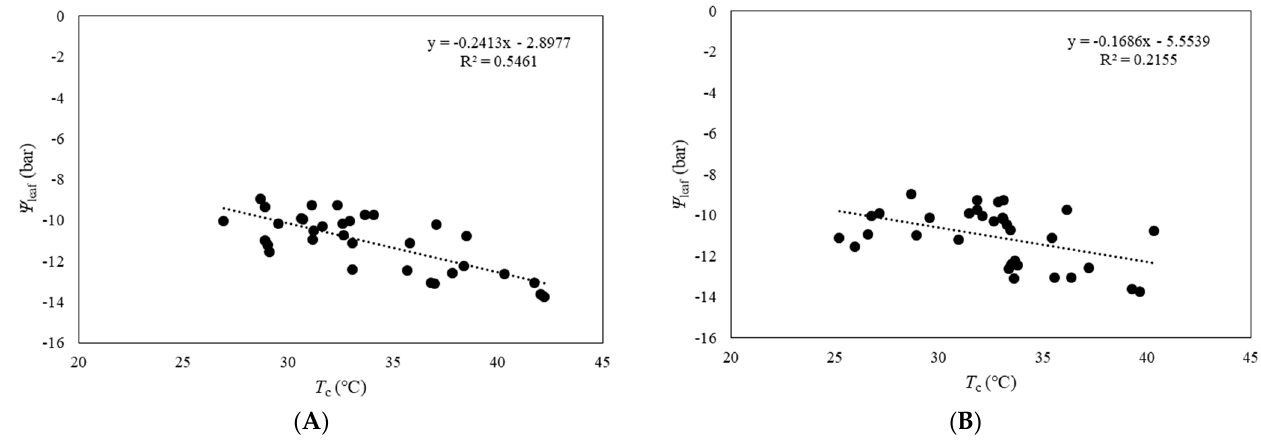
Figure 7. Correlation between T c and Ψ leaf in the ( A ) shaded side and ( B ) sunlit side of the vine canopies.